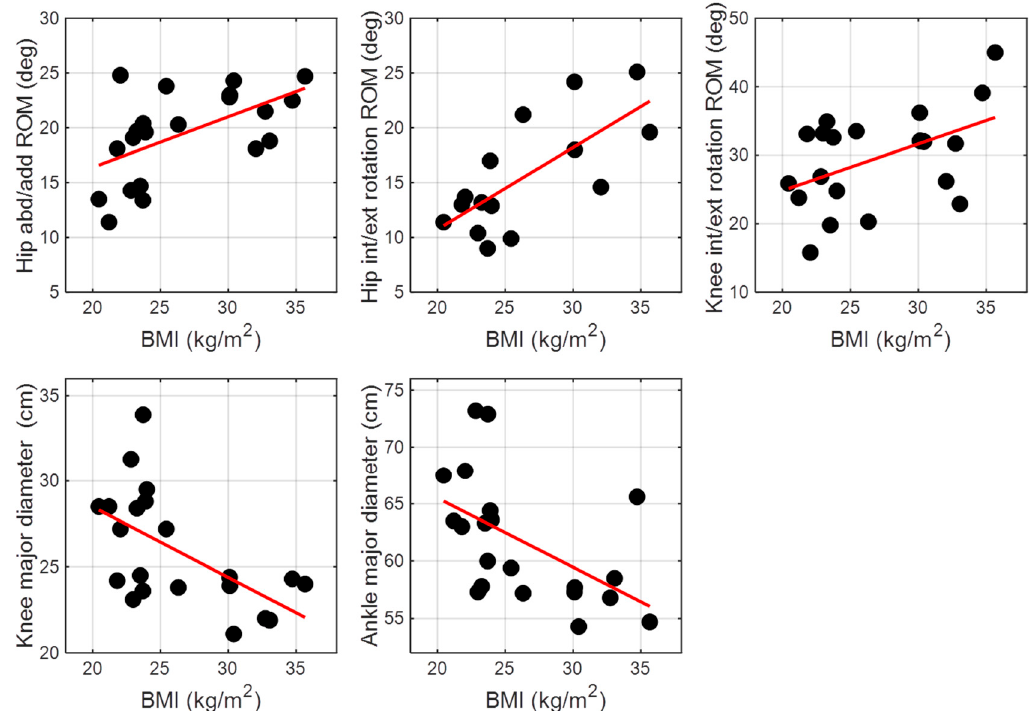
Figure 4. Significant correlations between BMI and joint kinematics parameters.